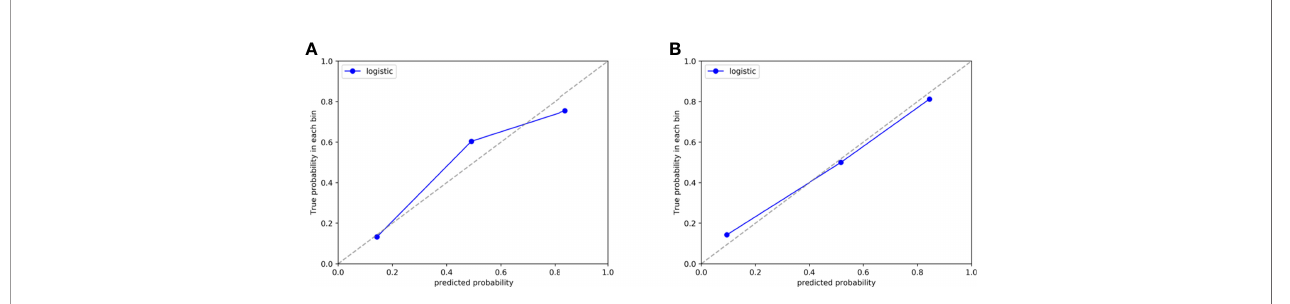
FIGURE 5 | Calibration curve of the AP+VP+NCP model developed by LR classi fi ers in the training (A) and test (B) cohort,